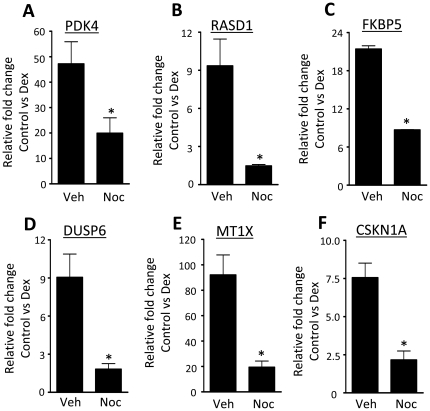
GR transactivation is dependent on cell cycle phase.HeLa cells were treated with nocodazole for 16 hours, washed and released into mitosis in the presence of vehicle or 100 nM dex for 4 hours. Cells were lysed, RNA extracted and analysed by qPCR using primers specific to PDK4 (A), RasD1 (B), FKBP5 (C), Dusp6 (D), MT1X (E) and CSKN1A (F). Graphs depict mean +/− SEM and are representative of three independent experiments. * indicates p<0.05 compared to vehicle control.